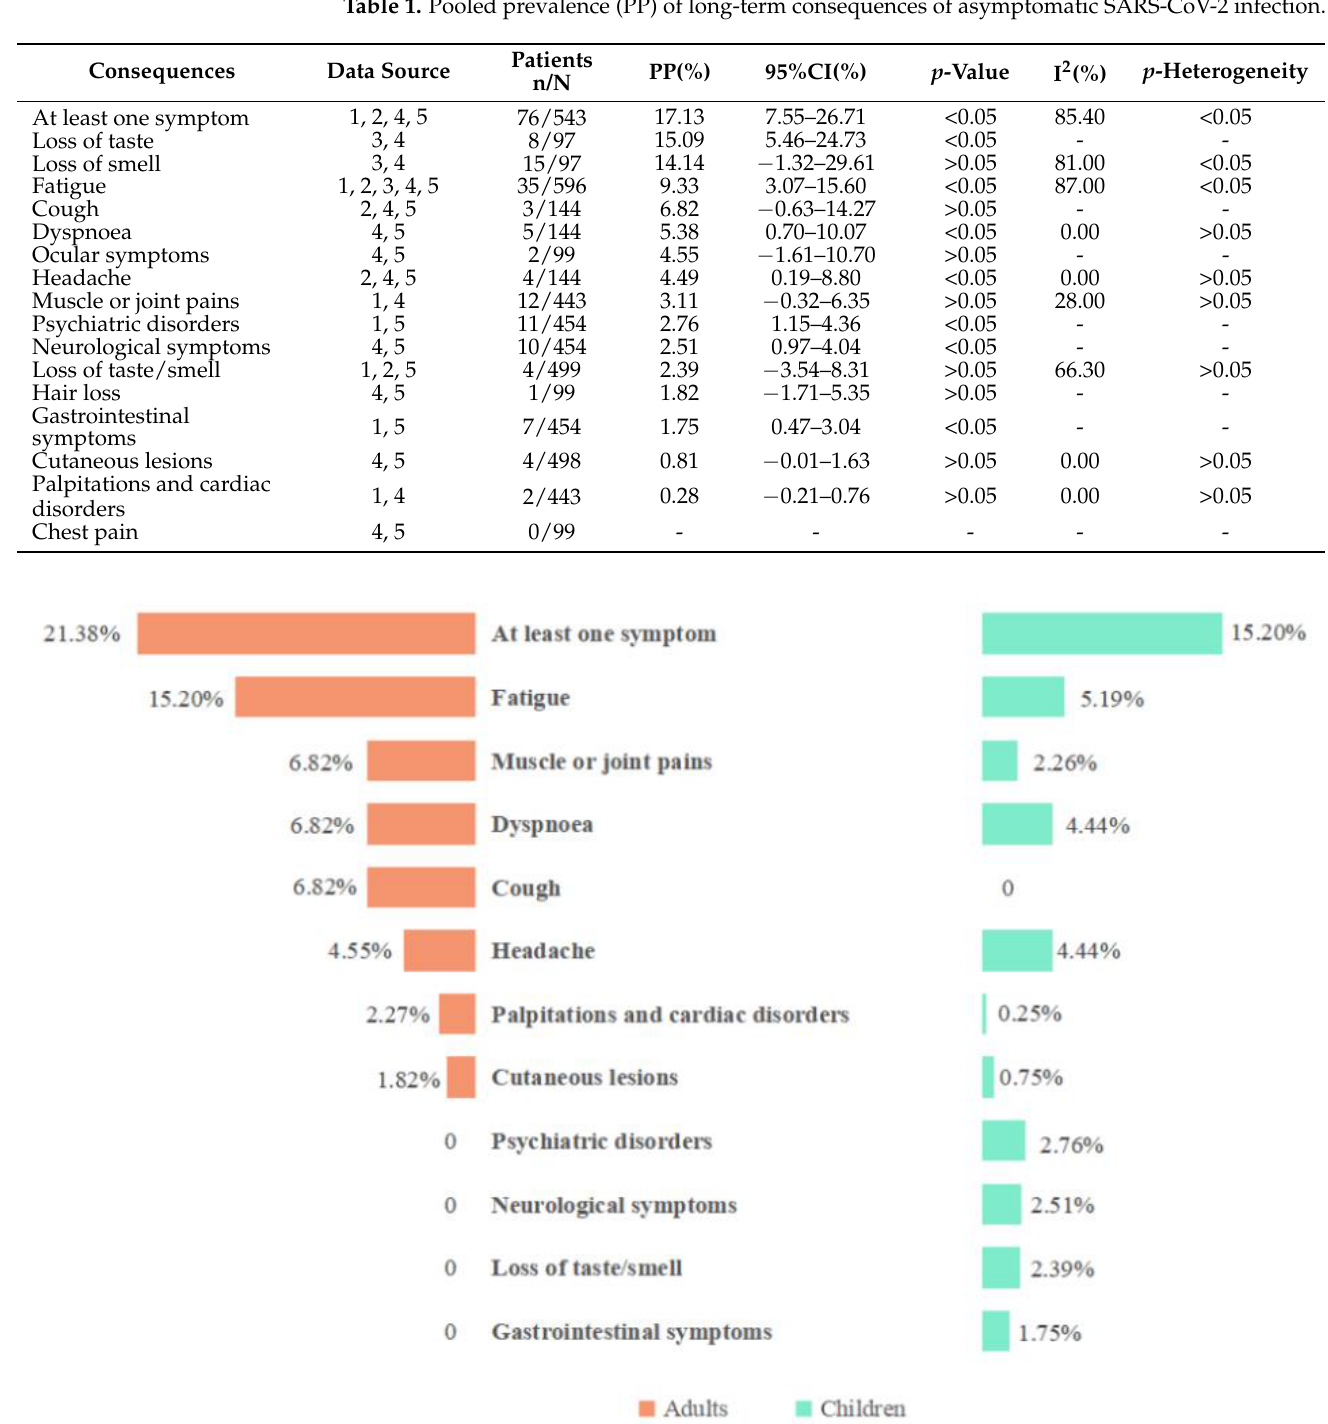
Table 1. Pooled prevalence (PP) of long-term consequences of asymptomatic SARS-CoV-2 infection.